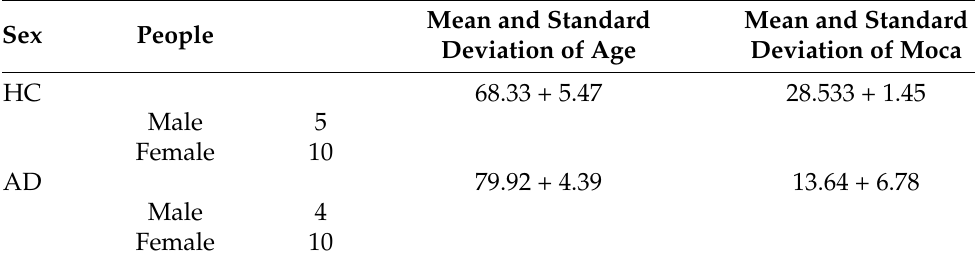
Table 1. Subject demographics of HC (Health Control) and AD (Alzheimer